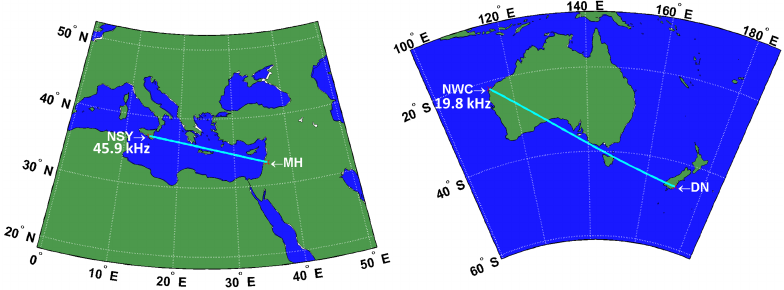
Figure 1. MH-NSY (left panel) and DN-NWC (right panel) transmitter–receiver great circle paths (GCP), together with their corresponding